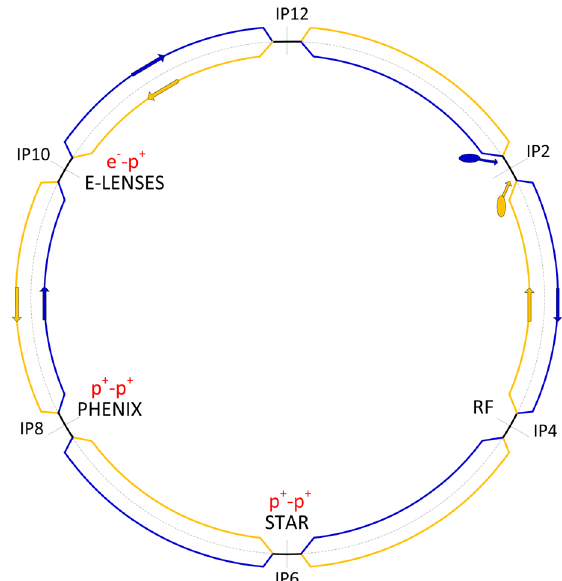
FIG. 1. The layout for head-on beam-beam compensation in the RHIC. Head-on proton-proton beam-beam interactions occur in IP6 and IP8, while head-on electron-proton beam-beam com- pensation is achieved in